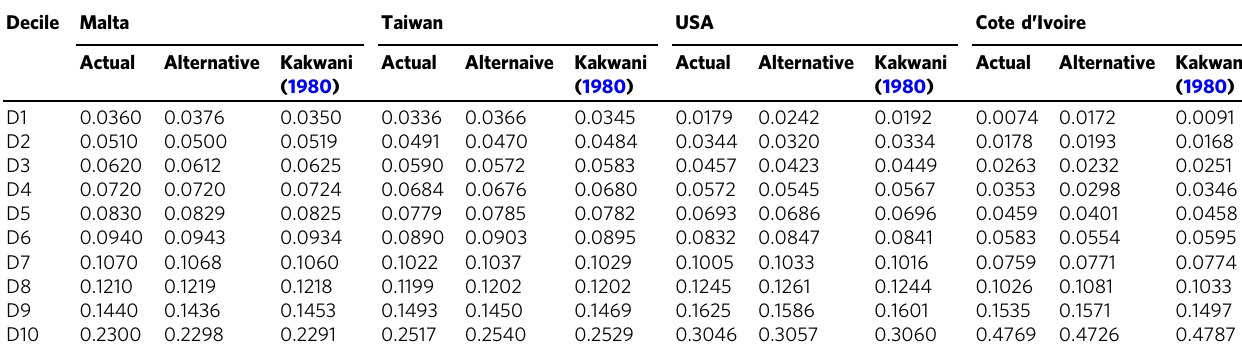
Table 8 The comparison of the estimated income shares by decile between the alternative functional form that is based on the weighted average of the exponential function and the functional form implied by Pareto distribution and the Kakwani (1980) ’ s functional